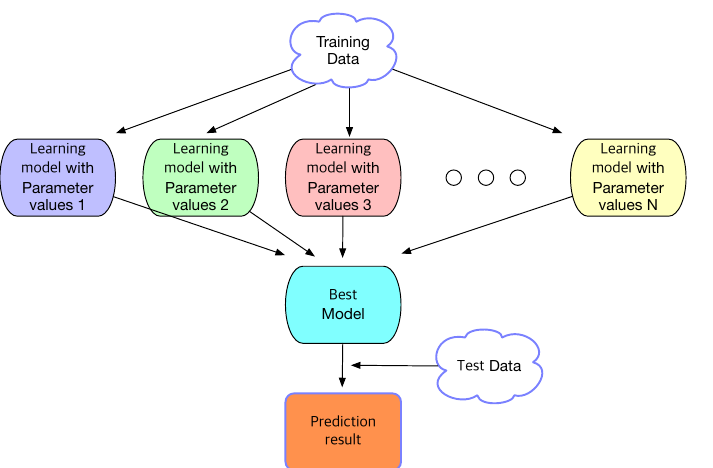
Figure 2. Flowchart of the grid search, which finds the right hyperparameters of a machine-learning model to achieve optimal